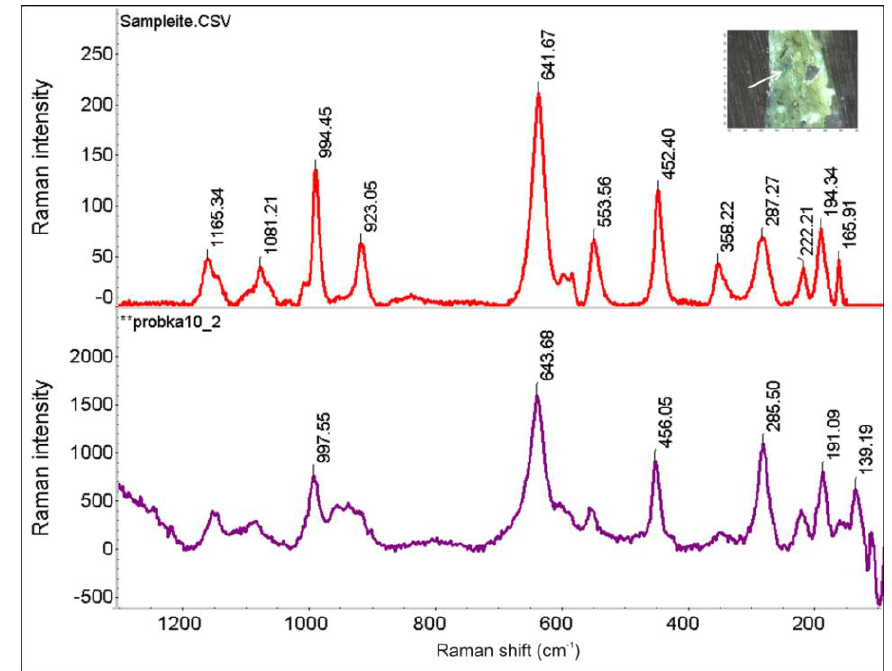
Figure 33. Comparison of the Raman spectrum of sampleite NaCaCu (upper plot) with the Raman spectrum from the green corrosion spot (lower plot) indicated on the small micro-photograph (right-top